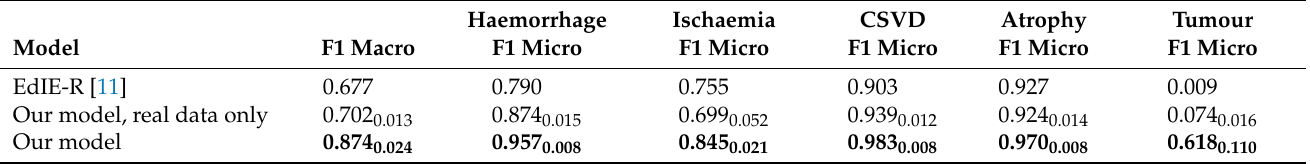
Table 9. We compare EdIE-R to our best model across five labels that overlap between the two annotation systems. We report the performance of EdIE-R against mean standard deviation of 10 runs with different random seeds for our approach. Results are for our independent test set. Bold indicates the best model for each metric. CSVD = cerebral small vessel disease . Haemorrhage Ischaemia CSVD Atrophy Tumour Model